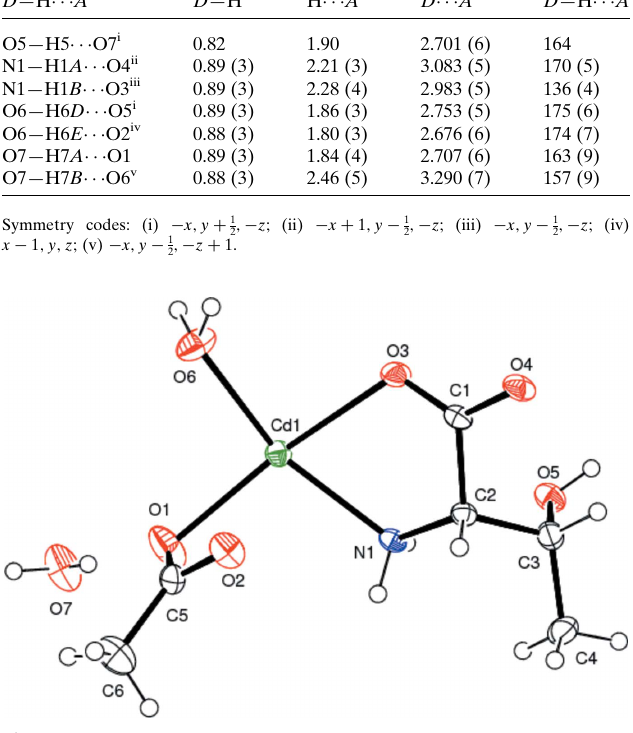
Figure 1 The asymmetric unit of the title complex, with displacement ellipsoids for non-H atoms at the 50% probability level.